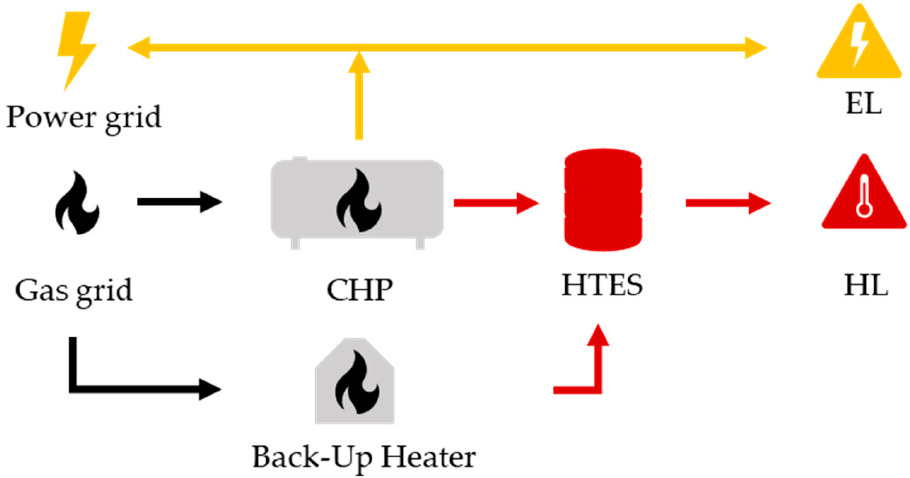
Figure 1. Schematic representation of the CHP scenario set-up.